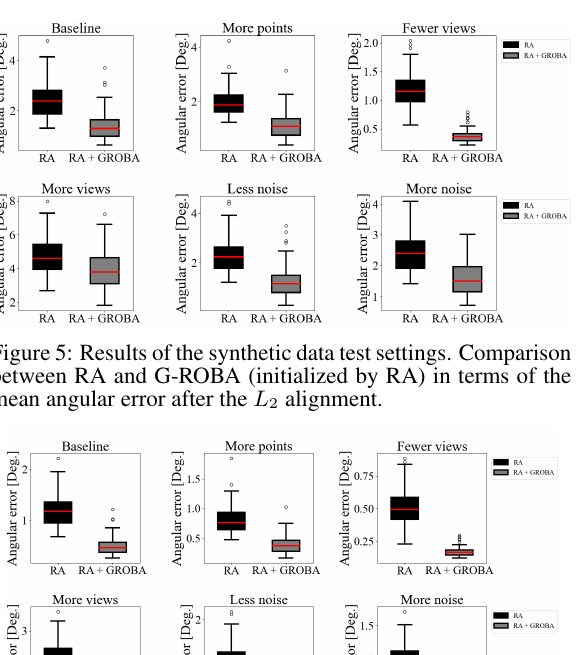
Figure 3: Simulated imaging configurations. (left) We simulate a block structure with n strips as the number of strips, each con- taining n views number of views. The rotations are perturbed by random angles θ ∼ U (0 , 5 ◦ ) ; (right) we uniformly distribute n cameras on a circle on the xy -plane such that the neighbors are evenly spaced along the circle perimeter. After aligning their optical axes with the z -axis, we perturb the rotations by random angles θ ∼ U (0 , 20 ◦ ) .